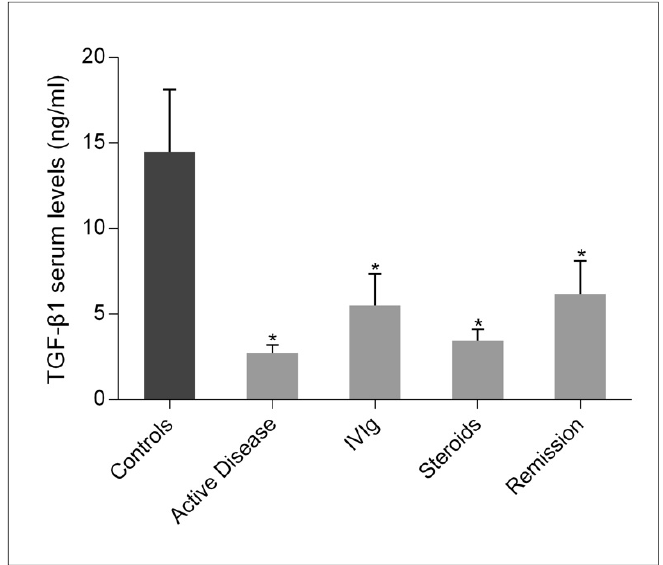
Figure 3. Plasma TGF- β 1 levels in controls and children with ITP in the acute phase, after treatment with IVIg and/or steroids, and in remission. TGF- β 1 levels are shown as mean (SD). Asterisks indi- cate statistically significant differences (* p < 0.05) compared to controls.